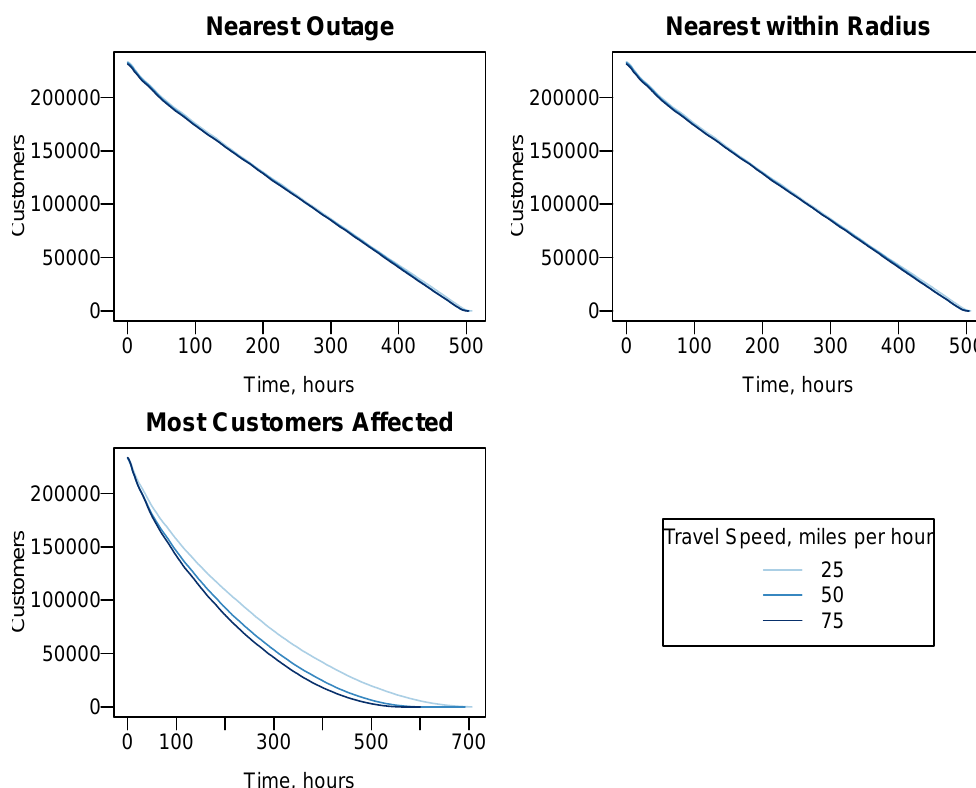
Figure 10. Travel speeds for simulated large storms with 5000 outages. Crew start location set to area work center and search strategy as indicated in plot title. Travel speed set as indicated in legend.